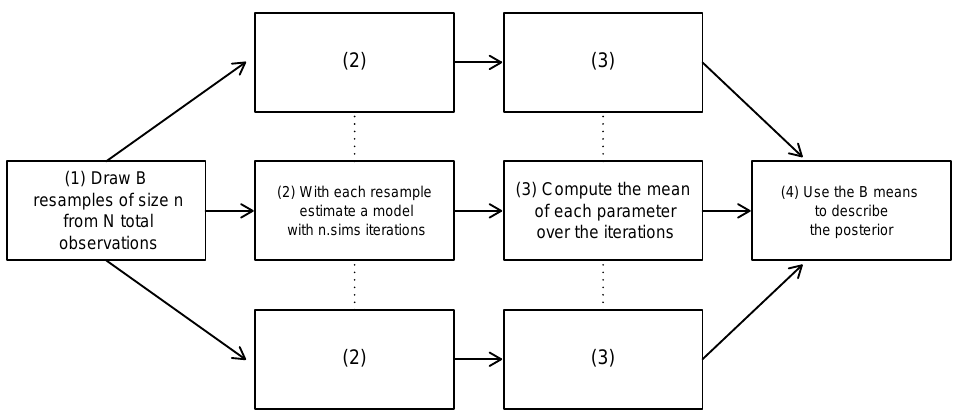
Figure 1. Flowchart Illustrating the Steps of